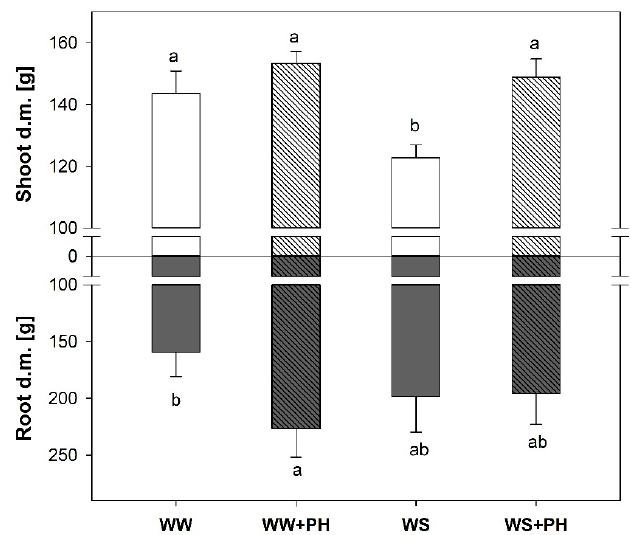
Figure 6. Effects of water stress (WS) compared with well-watered conditions (WW) and PH application, on dry matter partitioning among shoots (comprising the sum of the weight of the leaves and the primary and lateral stems, but not including the residual woody cutting), and roots. Values are means ± SE ( n = 4), different letters indicate significant differences according to Tukey’s test ( p < 0.05).